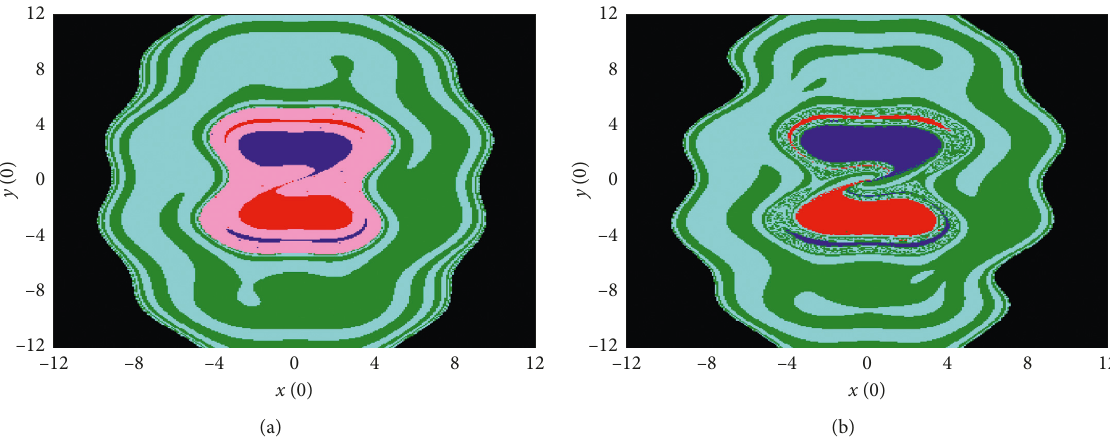
Figure 3: Two attraction basins in the x shown in Figure 2. (a) Attraction basin for k